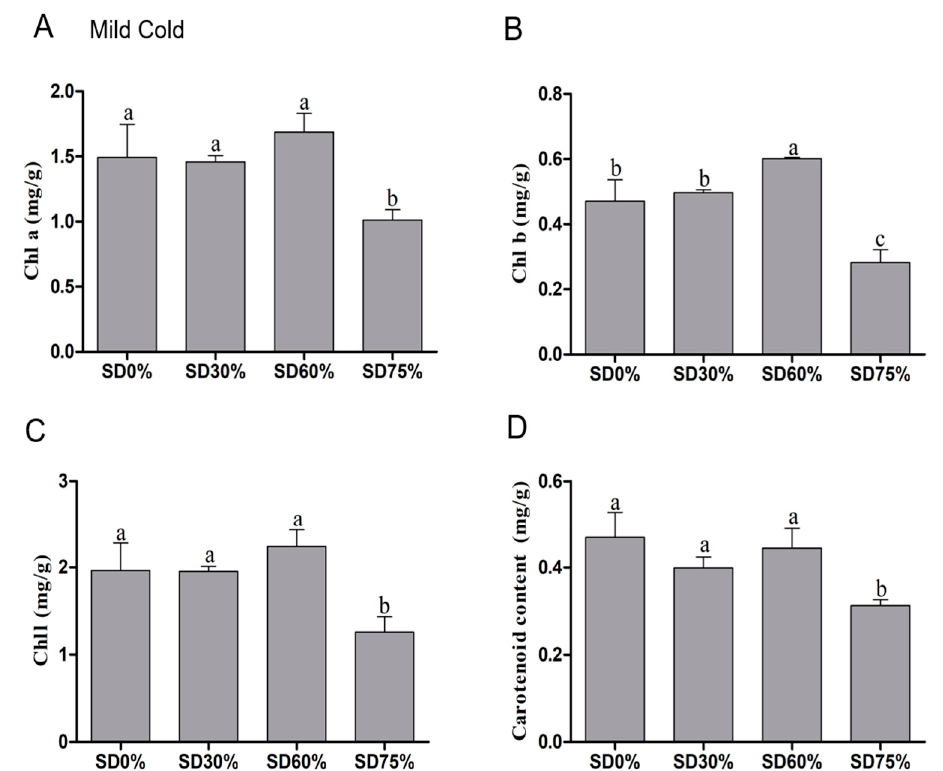
Figure 5. Effects of shading nets on ( A ) chlorophyll a, ( B ) chlorophyll b, ( C ) chlorophyll, and ( D ) carotenoid content during the mild cold condition. Different letters on the top of the columns within each figure represent significant differences between the treatments indicated by LSD test at p < 0.05.